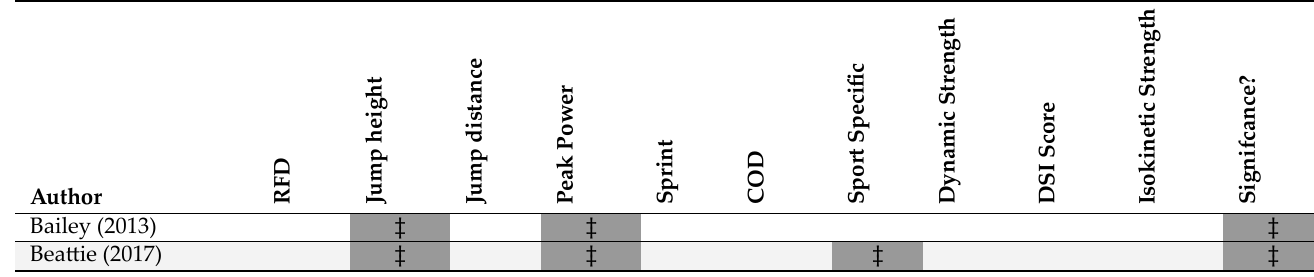
Figure 3. Sport distribution by study. Table 3. Analysis of significance of areas of interest. Abbreviations: RFD, rate of force development; COD, change of direction; DSI, dynamic strength index. Strength of associations were determined as: weak—r = 0.10–0.40 denoted by “ • ”; moderate—r = 0.41–0.70 as denoted by “ ‡ ”; strong—r ≥ 0.71 as denoted by “ ☆ .” Insignificant or lack of associations are denoted as ”x.”